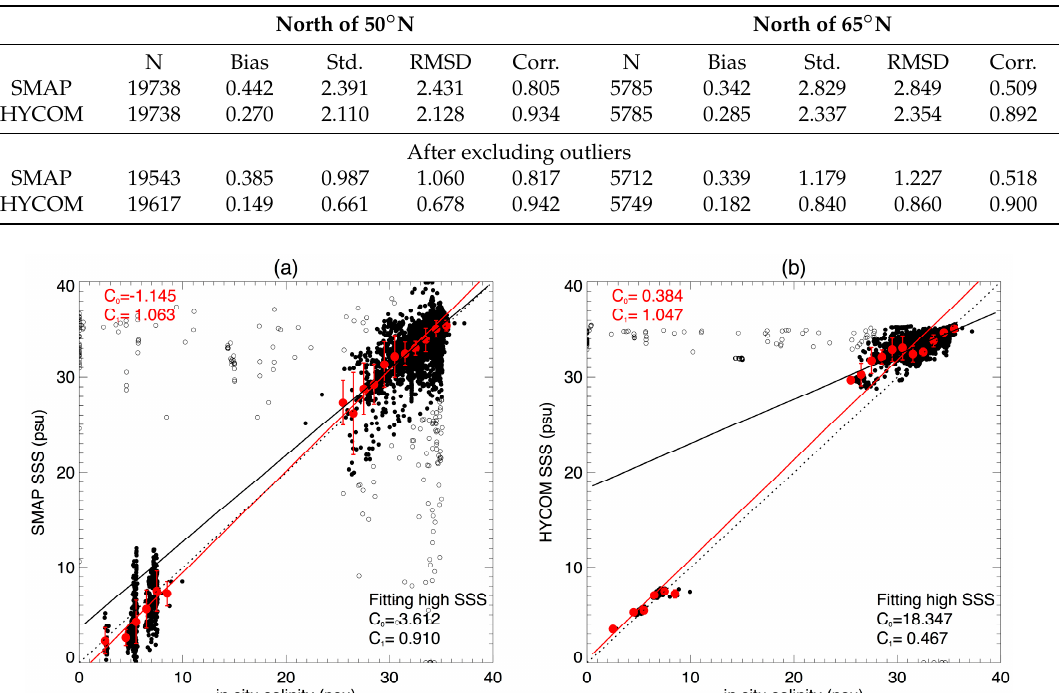
Table 1. Results of statistical comparison between in situ salinity and SMAP SSS (JPL V4.0) and HYCOM SSS, for North of 50 ◦ N or North of 65 ◦ N, respectively. All data are gridded on 0.25 ◦ grids averaged daily from April 2015 to March 2018. N is the number of collocated pairs; bias (data minus in situ), standard deviation (Std.) and Root Mean Square Difference (RMSD) are in psu; Corr. stands for the correlation coefficients.